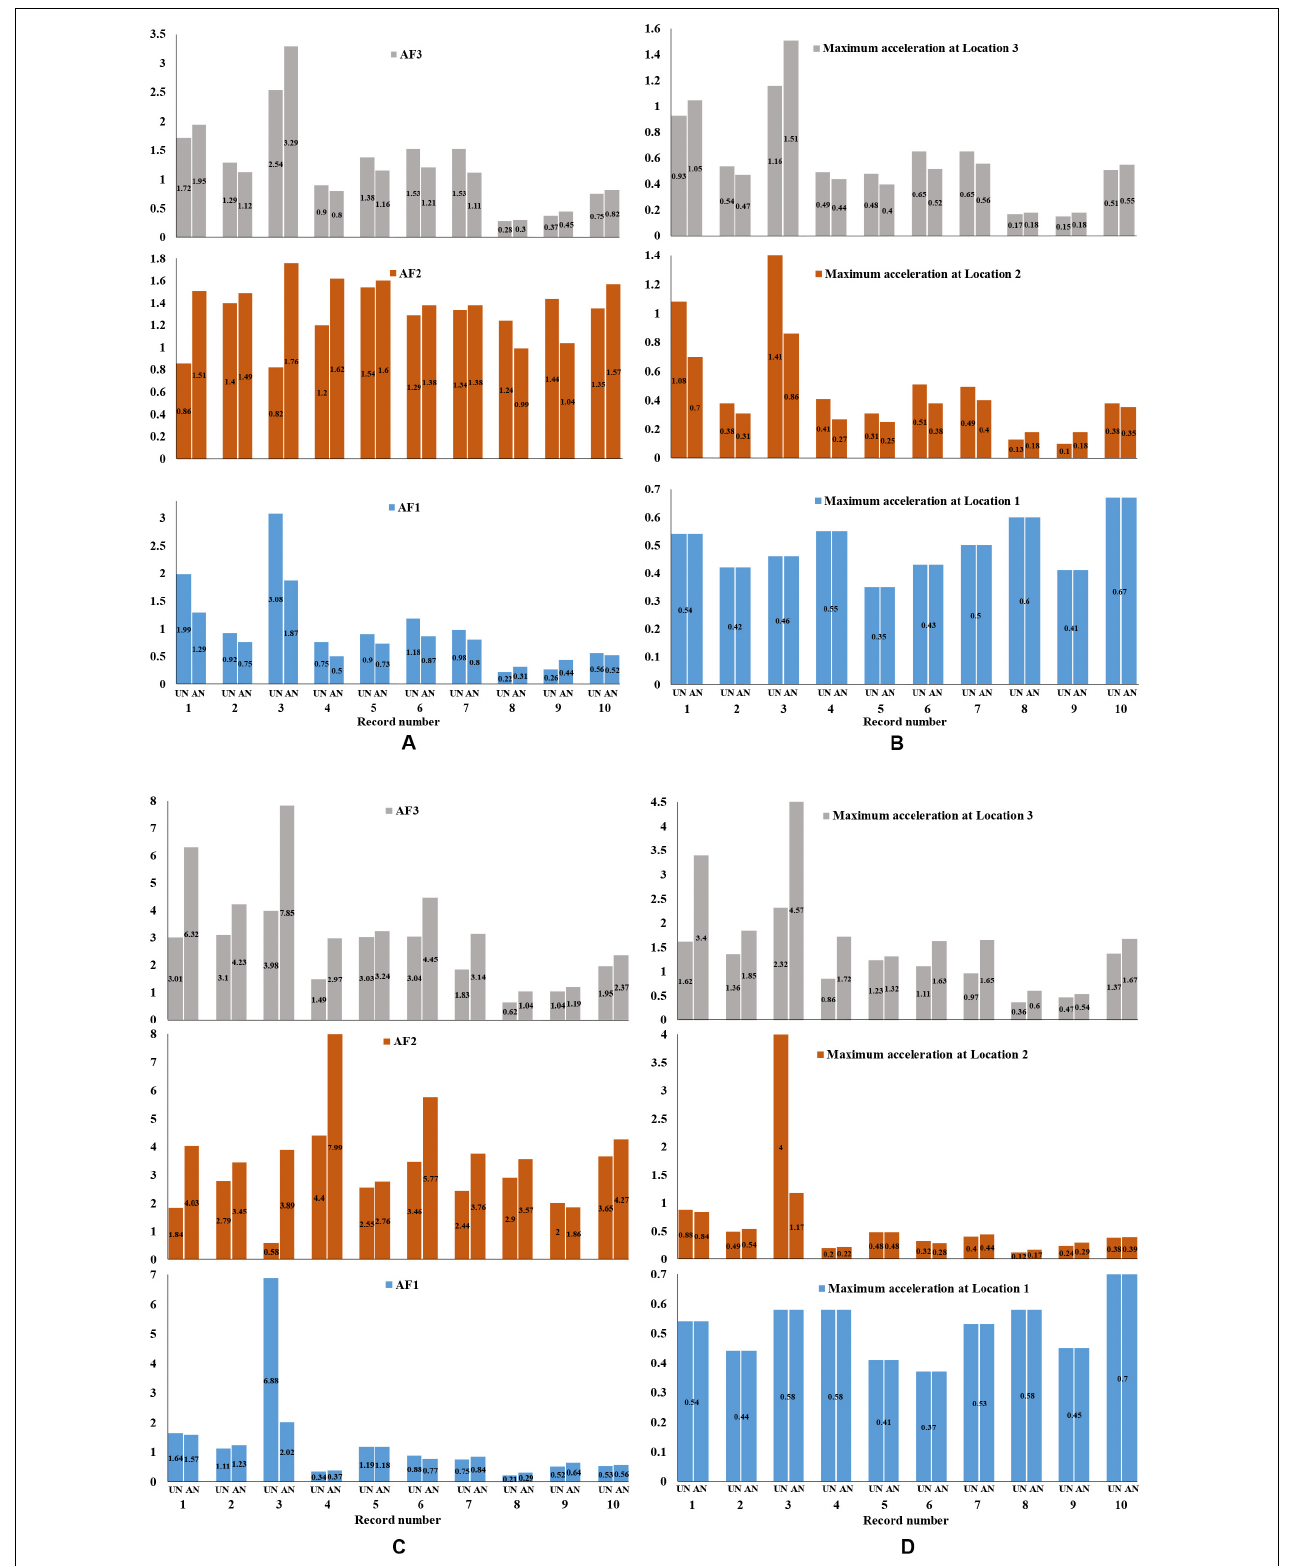
FIGURE 5 | Comparison of the amplification factors (A) and maximum accelerations (B) for the squat and amplification factors (C) and maximum accelerations (D) for the slender tank, for anchored (AN) and unanchored (UN) conditions (with friction coefficient µ 1 = 0.4).